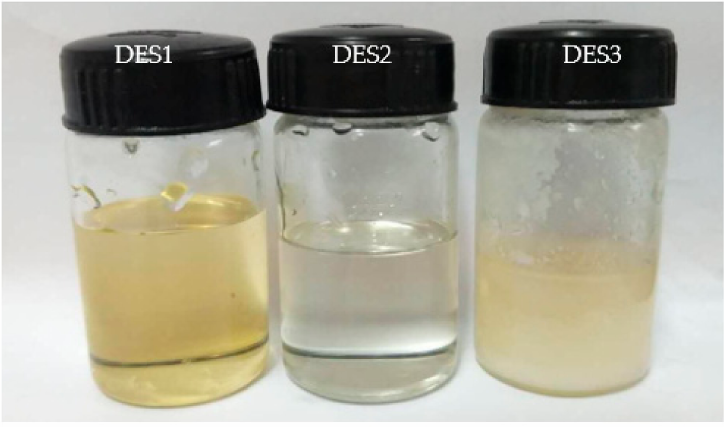
Figure 1. Experimental DES. From left to right were DES1, DES2,